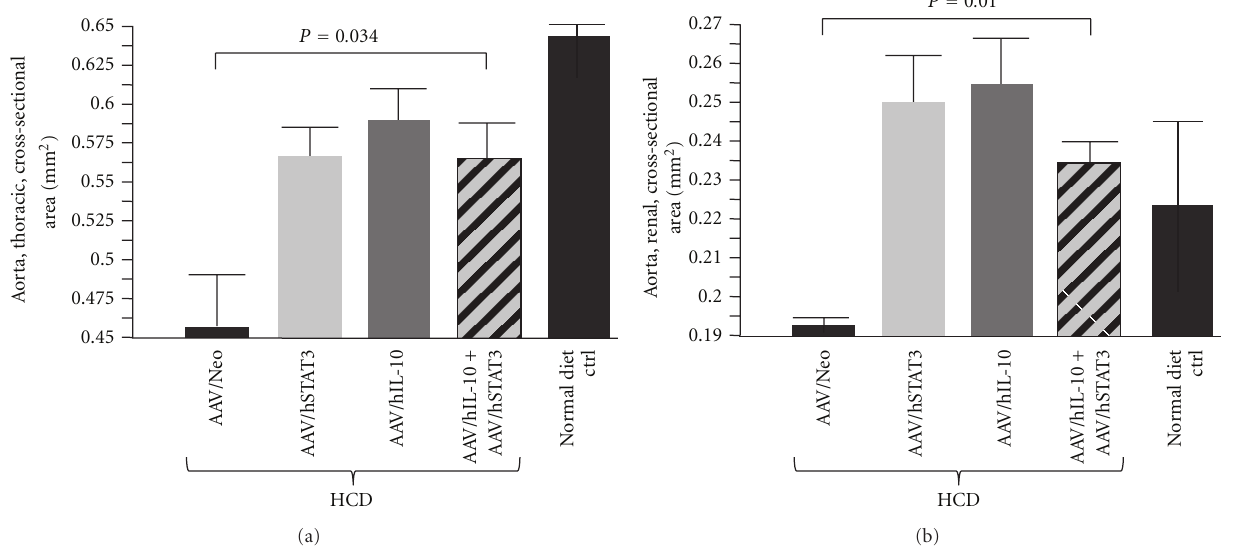
Figure 5: Analysis of the aortic lumen by high-resolution ultrasound (HRUS). HRUS was used to measure the cross-sectional area of the thoracic and renal regions of the aortas in 3–5 animals from each animal group. (a) shows quantification of the cross-sectional area for the thoracic region of the aorta. Note that the hSTAT3-treated, the hIL-10-treated, and the hSTAT3-plus-hIL-10-treated animals all had a much larger cross sectional area than the AAV/Neo-treated animals, indicating significant e ffi cacy. Similarly in (b), quantification of the data for the renal region of the aorta shows a much larger lumen size for the hSTAT3-, hIL-10-, and hSTAT3-plus-hIL-10-treated animals compared to AAV/Neo-treated animals.